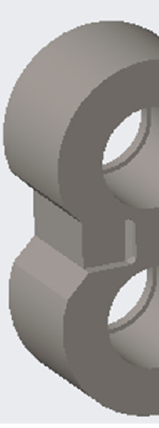
Figure 5. Shim view.